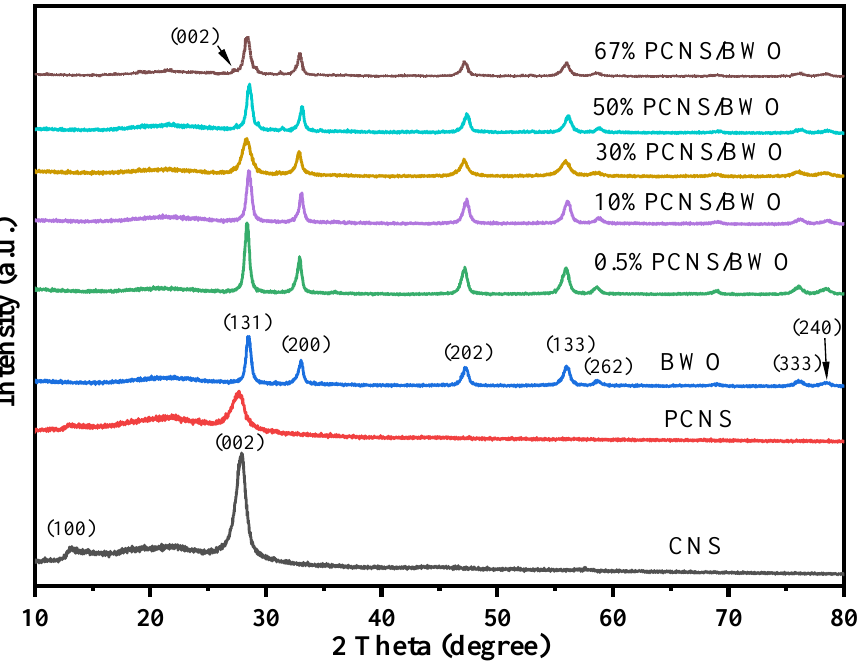
Figure 1. XRD patterns of the synthesized samples. The surface compositions and valence states of the samples were analyzed by XPS. From the XPS survey spectra shown in Figure 2a, PCNS contained C, N, O, and P; BWO contained O, Bi, and W; and 30% PCNS/BWO contained C, N, O, Bi, and W. The absence of P in the 30% PCNS/BWO survey spectrum is probably due to the low phosphorus content. The C 1s spectrum of 30% PCNS/BWO (Figure 2b) contained peaks at 284.8, 286.2, and 288.28 eV, which correspond to C–C, C–N, and N–C=N bonds with sp 2 hybridized C atoms, respectively [32]. The N 1s spectra (Figure 2c) contained peaks at 398.68, 400.19, and 401.38 eV, corresponding to C–N=C, N–(C) 3 , and C–NH 2 bonds, respectively [33]. The O 1s spectra (Figure 2d) contained a single peak at 530.08 eV representing the Bi–O bond [34]. In the P 2p spectra (Figure 2e), three peaks at 133.27, 134.07, and 135.32 eV were observed, which correspond to P–N, P=N, and P=O bonds, respectively. This demonstrates that P–N and P=N covalent bonds form between the substitutional P atoms and adjacent N, and P=O bonds form between the P atoms and O from the air during the hydrothermal synthesis process [35]. These findings indicate that P was successfully doped into the CNS. The Bi 4f spectra (Figure 2f) contained Bi 4f 7/2 and Bi 4f 5/2 peaks at 159.26 and 164.51 eV, respectively, indicating the existence of Bi 3+ [36], while the W 4f spectra (Figure 2 g) contained W 4f 7/2 and W 4f 5/2 peaks at 35.44 and 37.54 eV, respectively, indicating the existence of W 6+